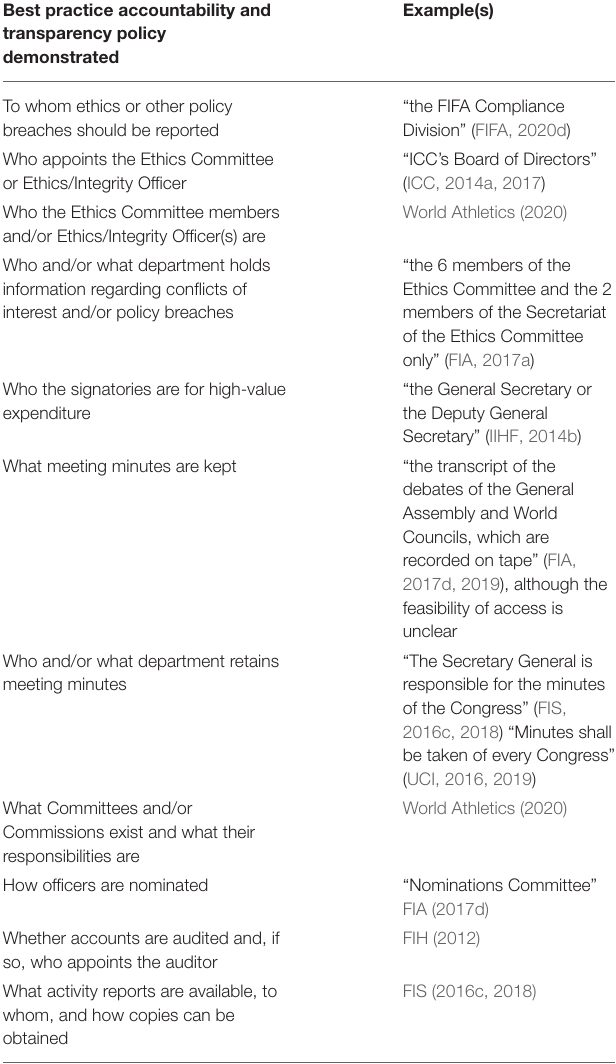
TABLE 2 | Examples of best practice accountability and transparency